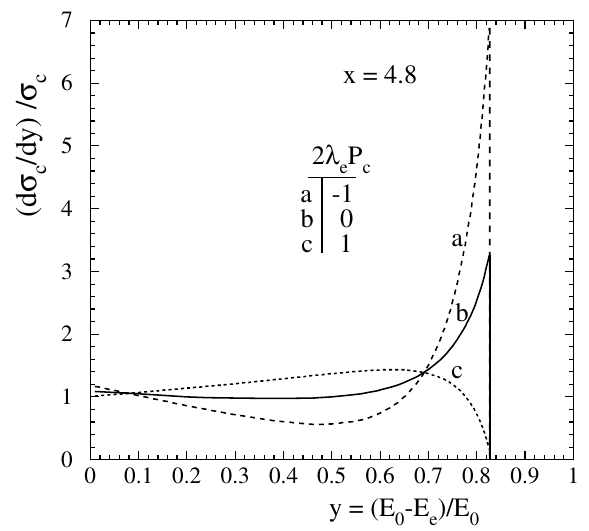
FIG. 4. Spectrum of the Compton scattered electrons for various relative polarizations of laser end electron beams.